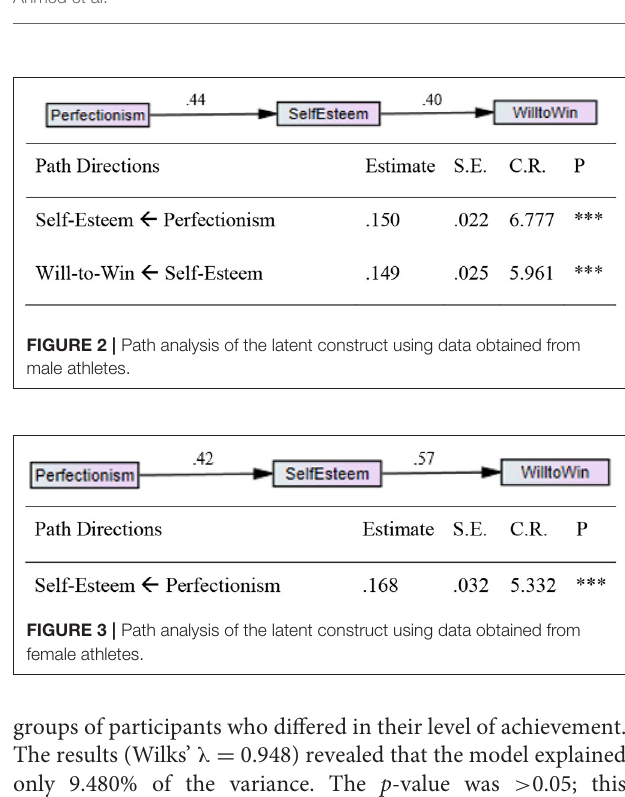
groups of participants who differed in their level of